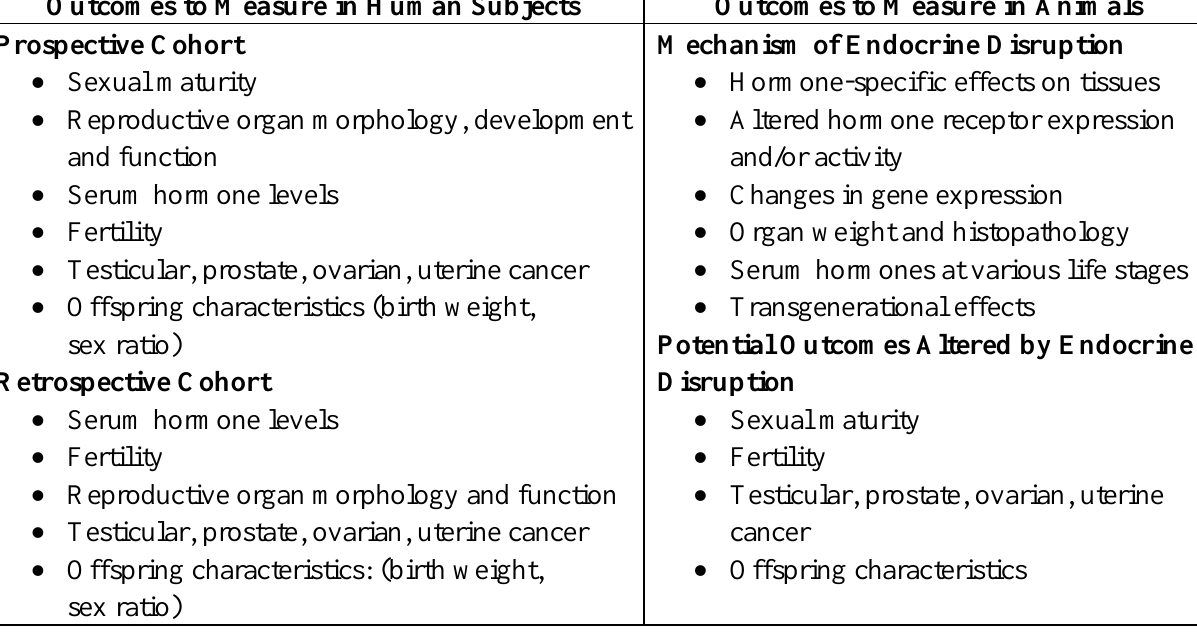
Table 7. Future directions for human studies or using animal